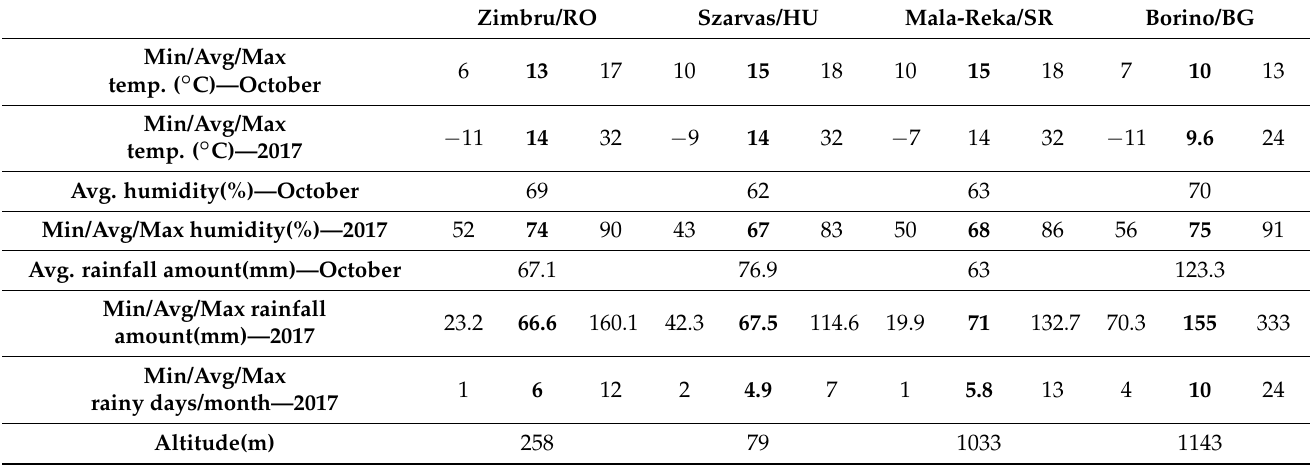
Table 4. Climatic conditions and altitudes for Ilex aquifolium population sampling areas.